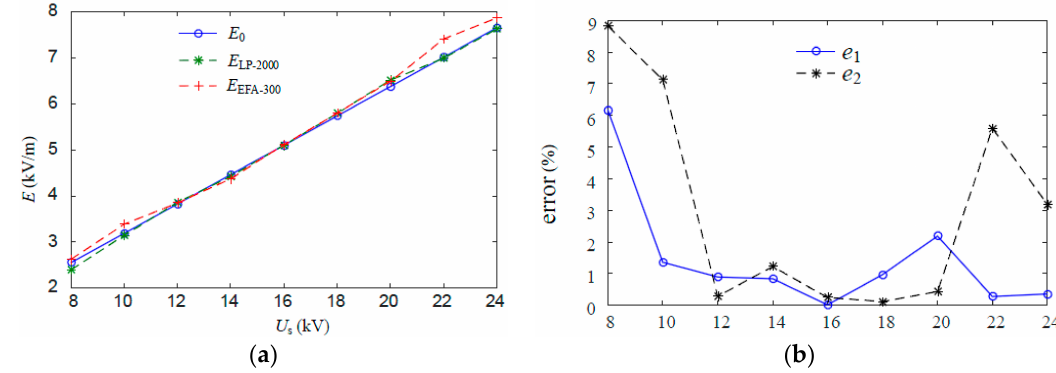
Figure 10. Relation curves related to the excitation voltage variation (in the absence of a human body).